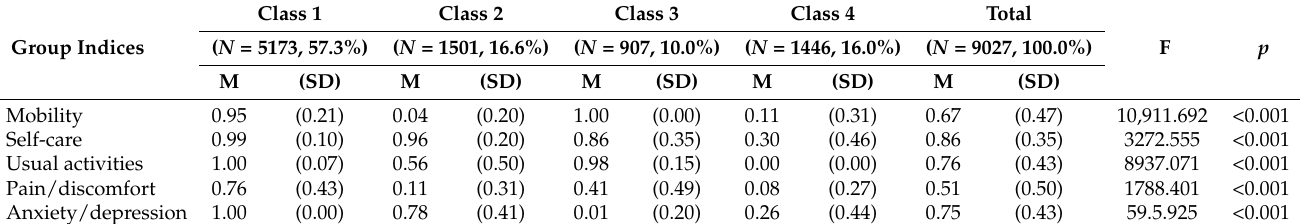
Table 3. Differences in indices of health-related quality of life among latent classes.